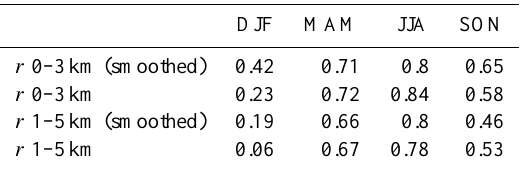
Table 2. Correlation coefficients between the deseasonalized smoothed LMDZ and IASI δ D, and between the deseasonalized LMDZ and IASI δ D for four seasons and both altitude ranges (0– 3km and